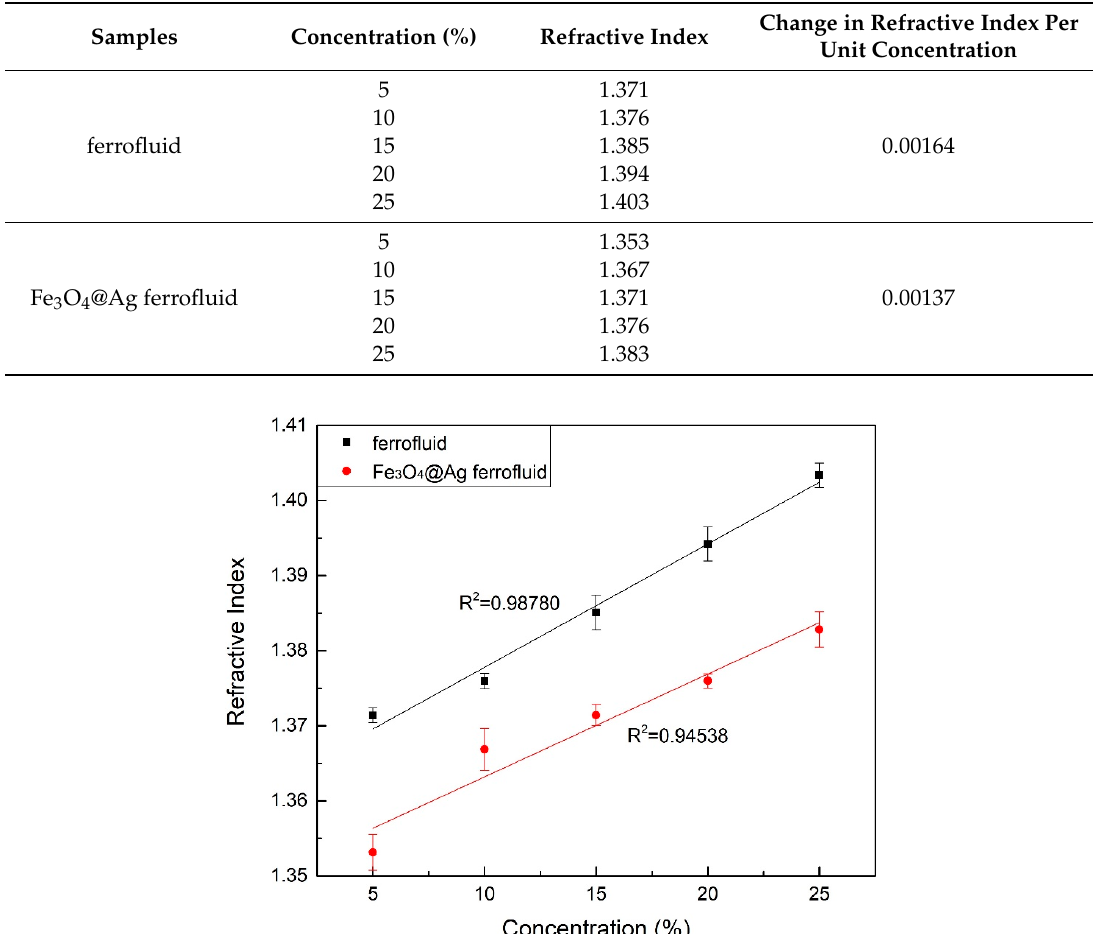
Figure 8. Transmission spectrum of the LPG optical fiber sensor in ( a ) ferrofluid and ( b ) Fe 3 O 4 @Ag ferrofluid. Table 2. Refractive index of ferrofluid and Fe 3 O 4 @Ag ferrofluid.